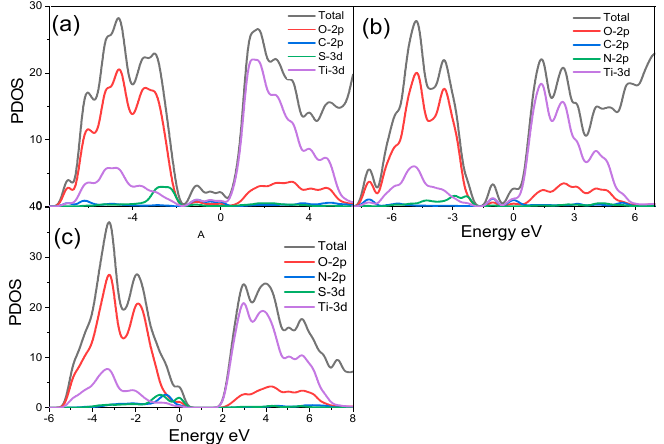
Figure 4. Calculated density of states (DOS) of ( a ) C,S-doped, ( b ) C,N-doped and ( c ) S,N-doped (210) surface. Table 2. Mulliken population analysis of (210) brookite surface for s, p, and d